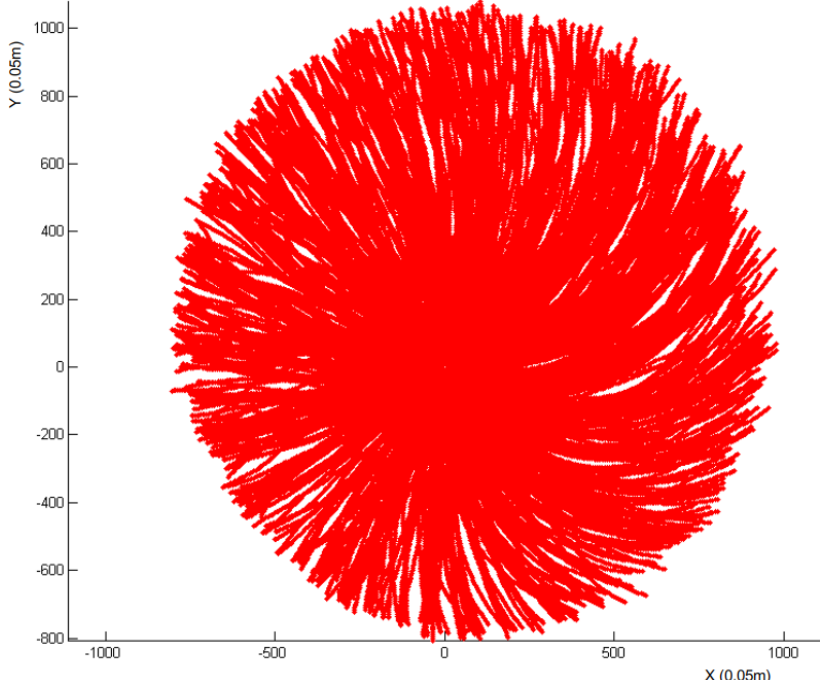
Figure 4. Reachable points of the rudder angle at 15°; the heading is explored at 0.5°